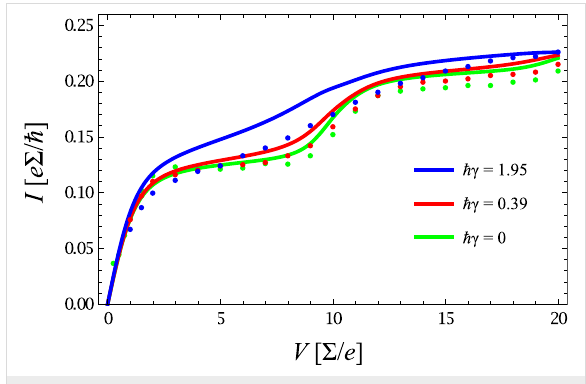
Figure 8: I – V characteristics in presence of a secondary heat bath interacting with the phonon with various coupling constants γ . Shown are approximate results (solid) using Equation 20 and diagMC data (dots); energies are scaled with ∑ . Other parameters are k B T / ∑ = 0.2, m 0 = 4/5, σ =